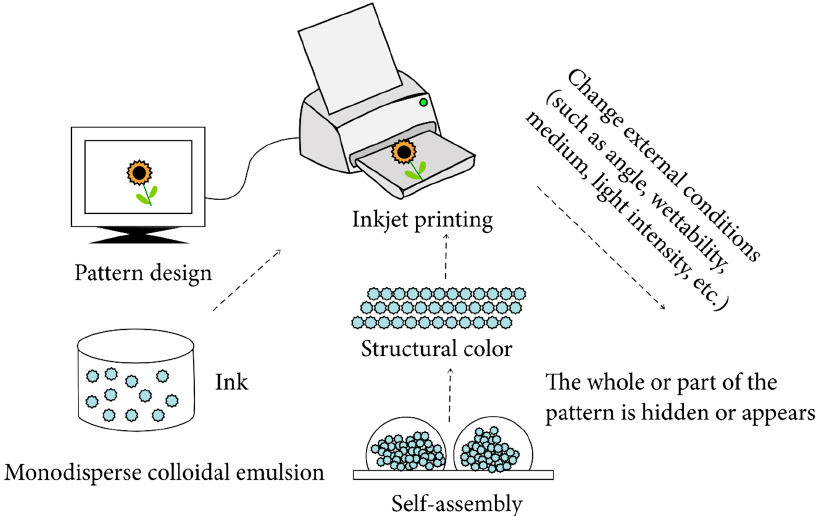
Figure 8. A schematic of the fabrication mechanism of anti-counterfeiting labels using AgNWs. Reproduced from Ref. [54] under the Creative Commons Attribution 4.0 International (CC BY 4.0) License.